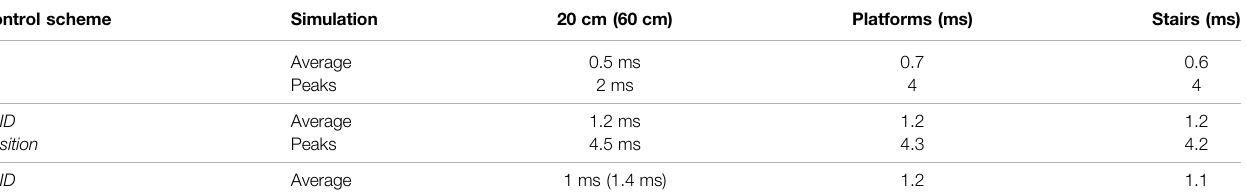
TABLE 8 | Comparison of execution time. Control scheme